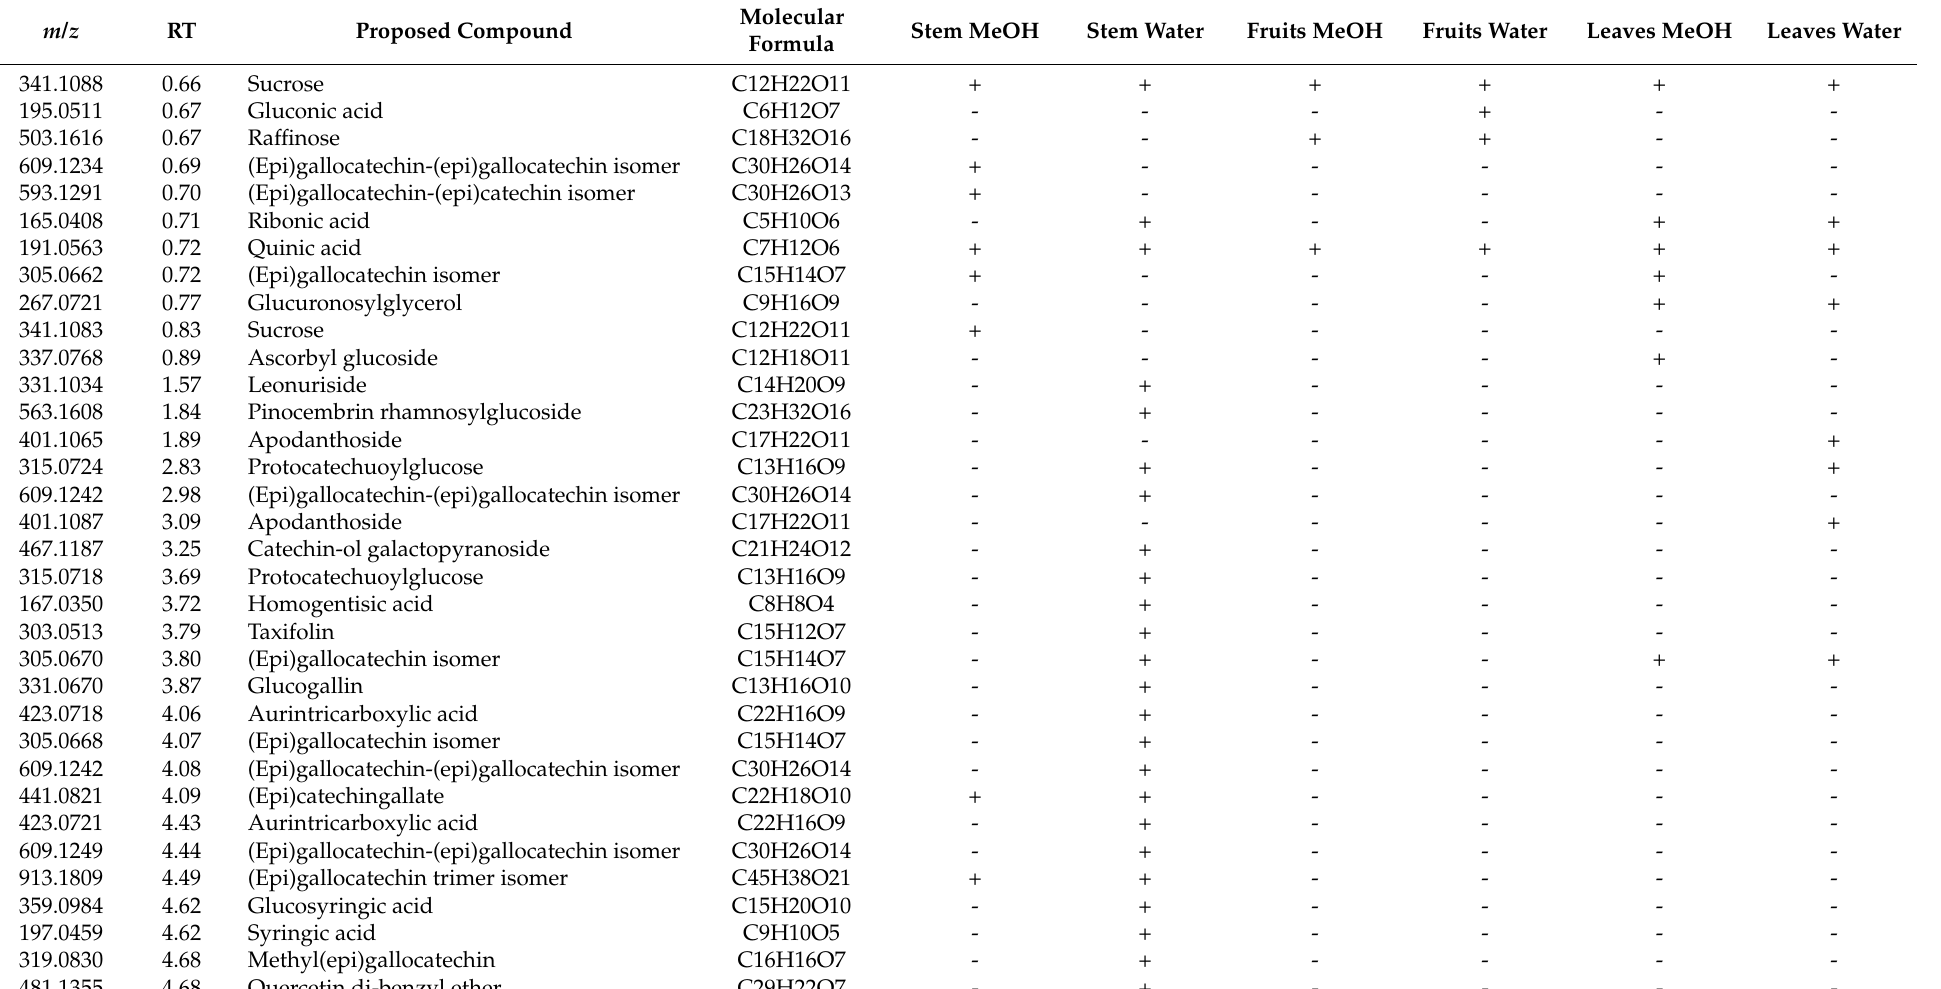
Table 1. Annotated compounds in methanol and water Paliurus extracts from stems, fruits and leaves by